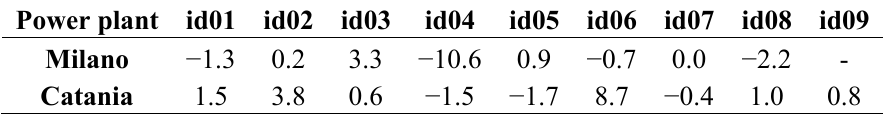
Table 5. Model bias for Milano and Catania. Bias is expressed as percentage of NP